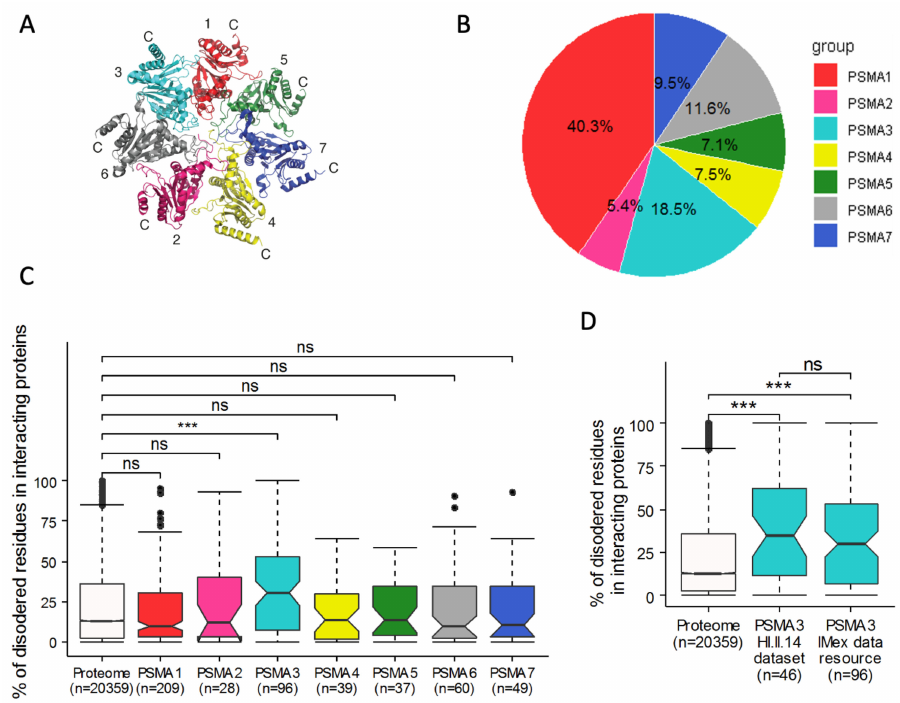
Figure 1. PSMA3 preferentially interacts with IDPs. ( A ) Crystal structure of PSMA ring [38]. PSMA subunits are identified by numbers. The N termini of the PSMA subunits protrude into the center of the ring, forming a gate restricting access into the 20S proteasome. ( B ) Pie chart presenting